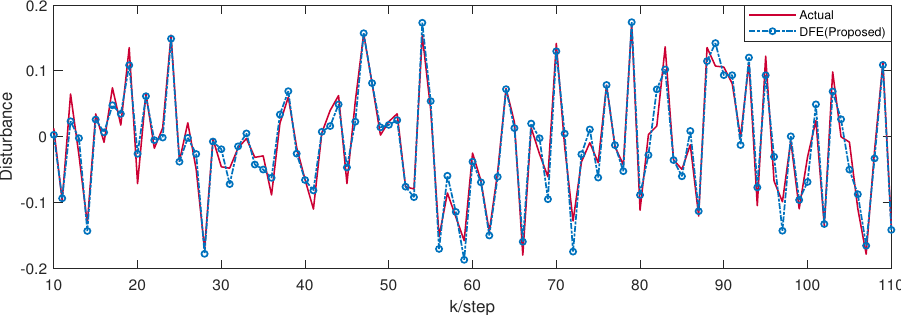
Figure 3. The trajectories of the system disturbance w ( k )